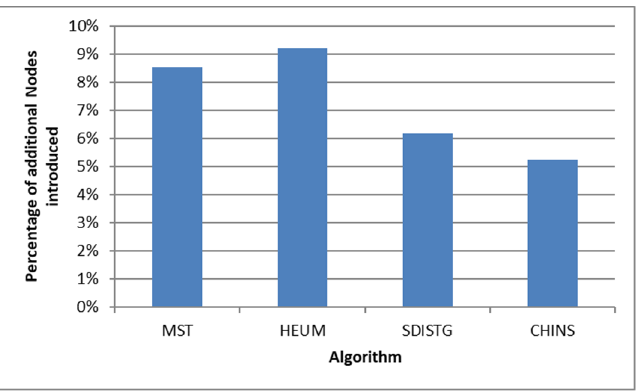
Figure 6. The percentage of additional nodes introduced for linking the top-k nodes.